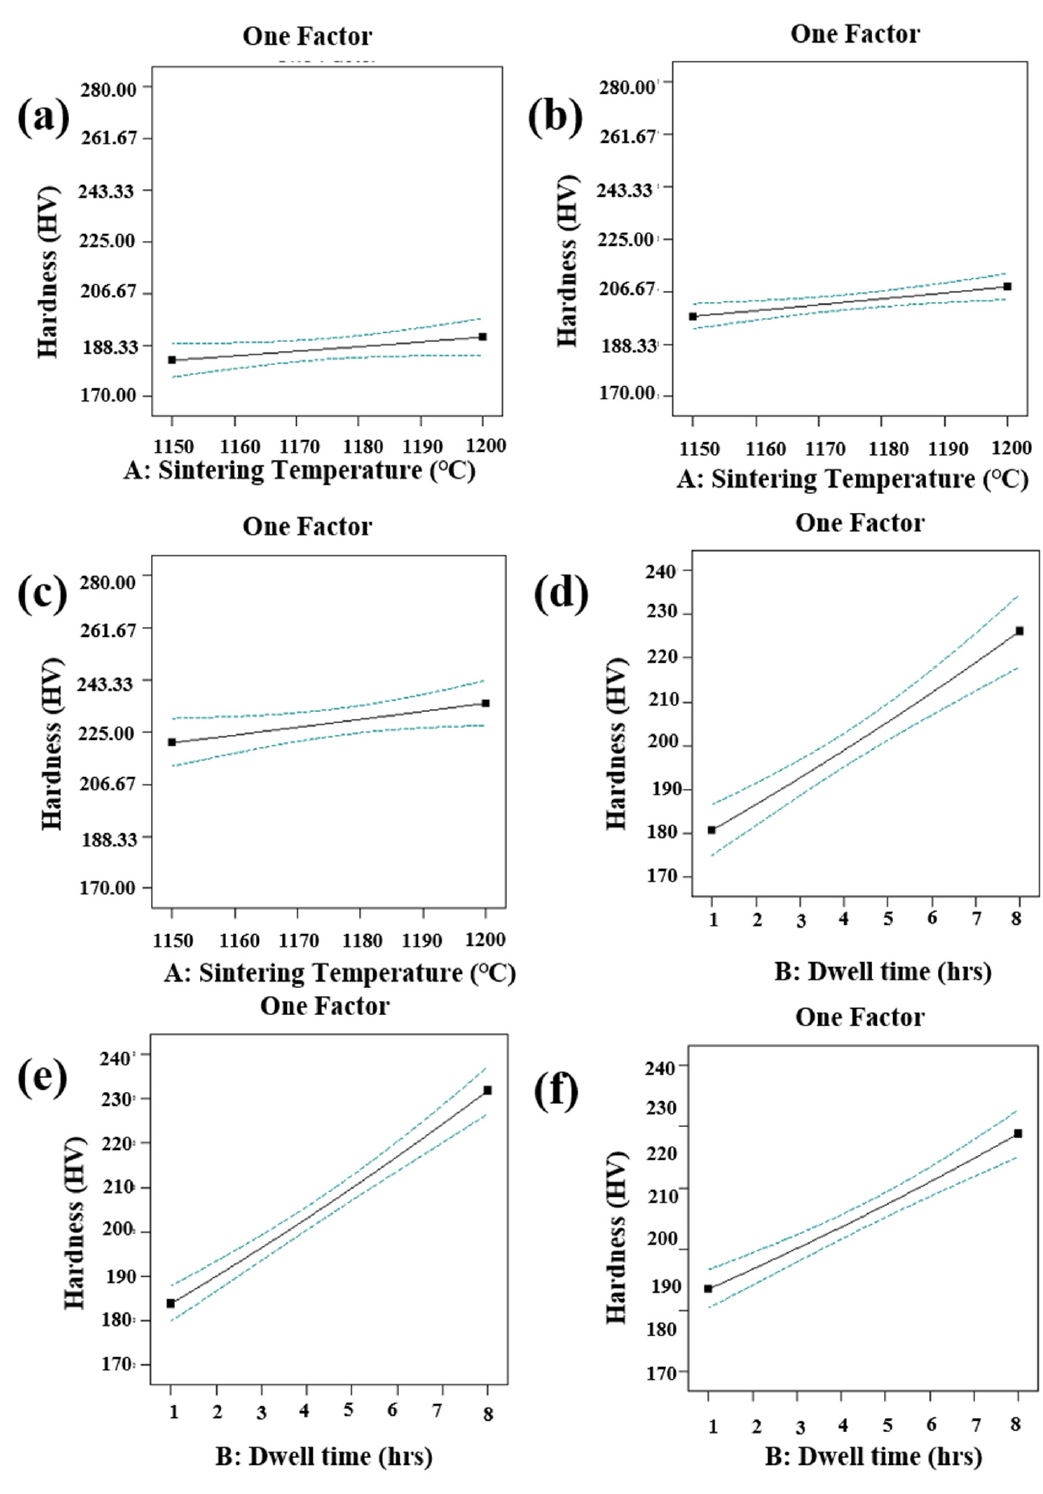
Figure 16. One factor effect plot for micro hardness.